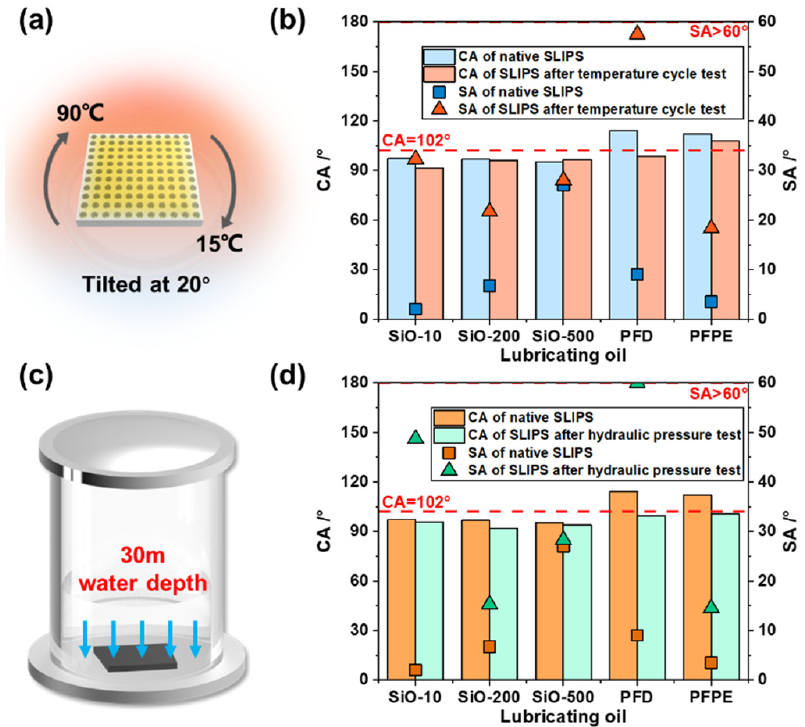
Figure 5. Durability test implemented on the SLIPS samples: ( a – d ) CA and SA of five lubricant-infused surfaces before and after the temperature cycle test and the hydraulic pressure test. The CA and SA of the NiTi alloy after 7 days are marked by the red lines.